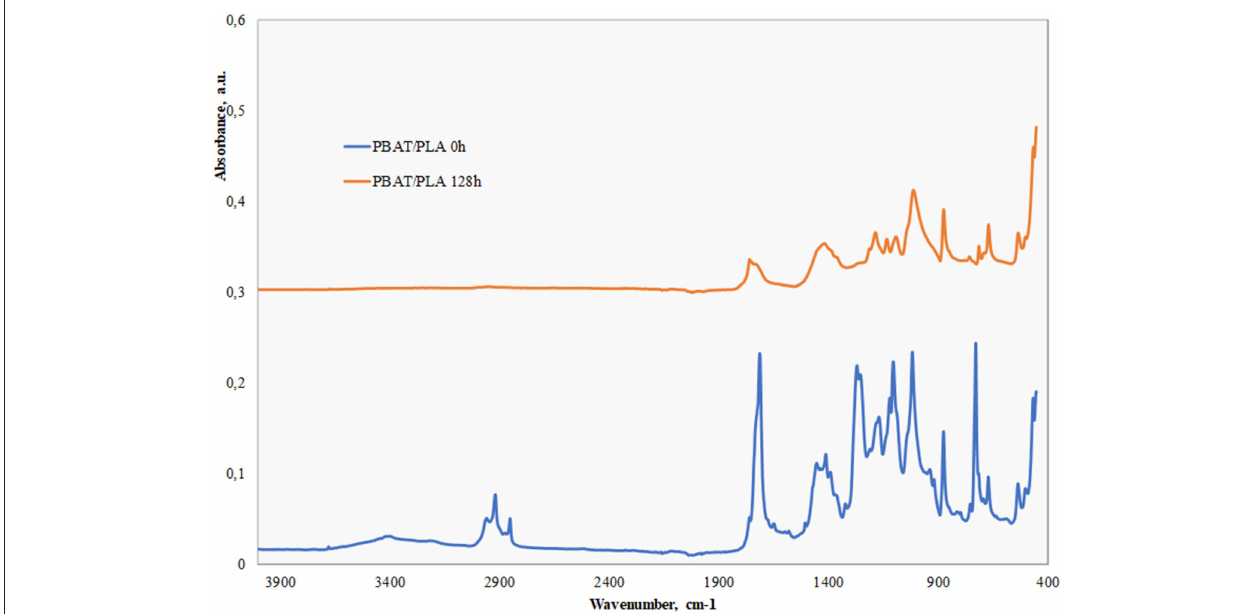
FIGURE 4 | ATR spectra of pristine and photooxidized blend.